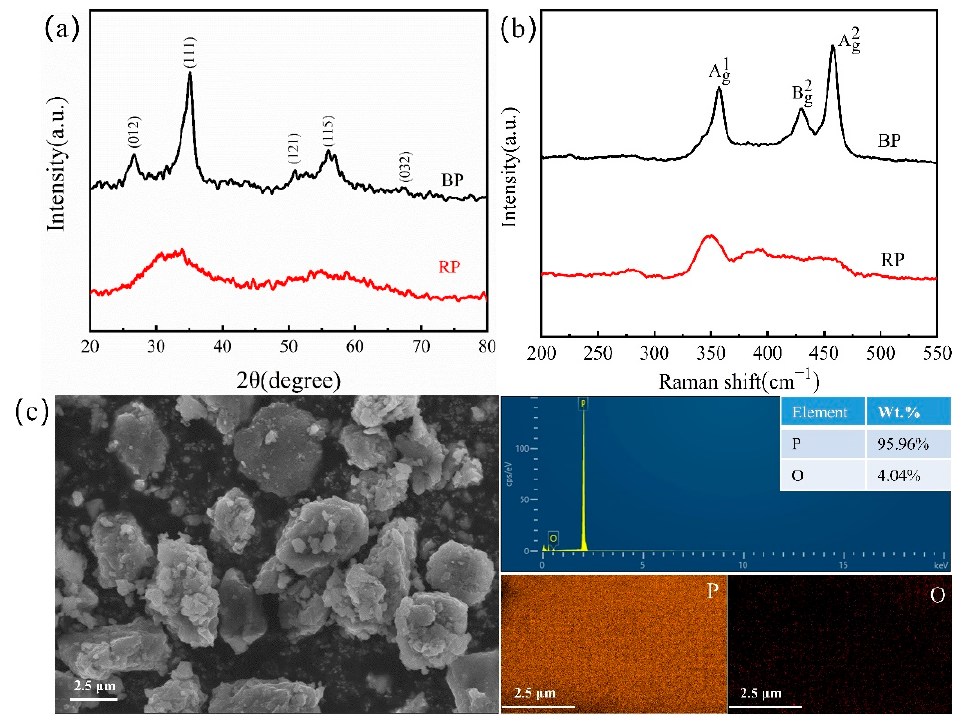
Figure 2. ( a ) XRD and ( b ) Raman patterns of RP and BP. ( c ) SEM image and EDS of BP powders.